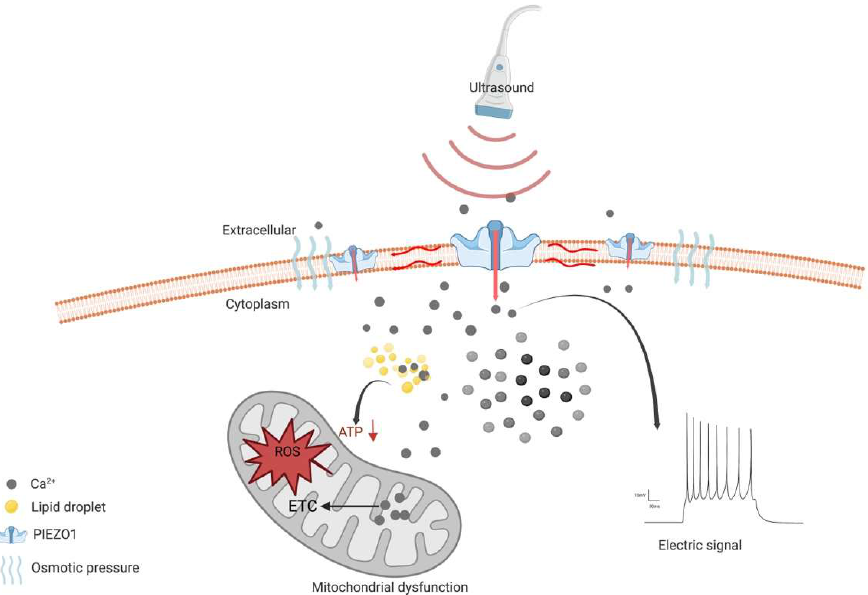
Figure 2. Schematic diagram of the mechanism of PIEZO1 as an anti-glioma therapeutic target. PIEZO1 is activated by ultrasound and constantly opens, leading to Ca 2+ influx and increased